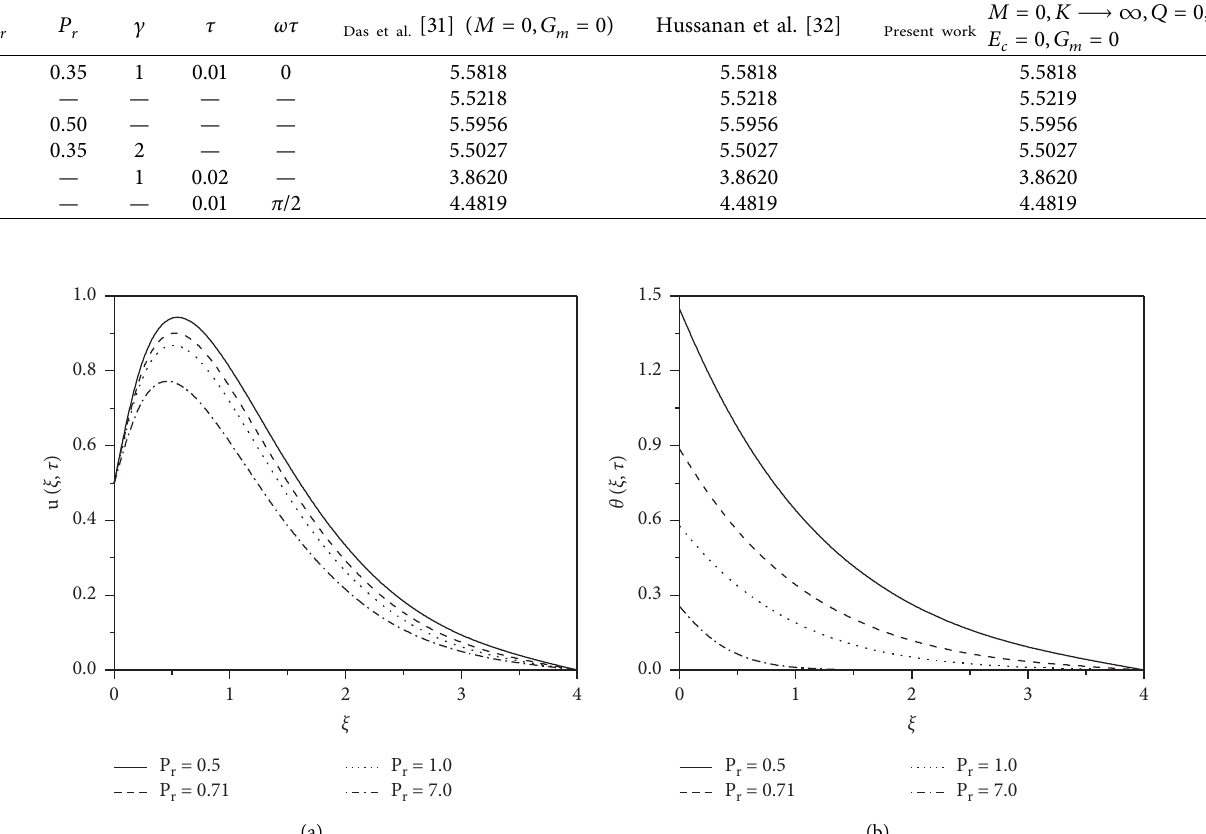
Figure 2: Variation of (a) velocity u ( ξ , τ ) and (b) temperature θ ( ξ , τ ) against ξ for various values of P